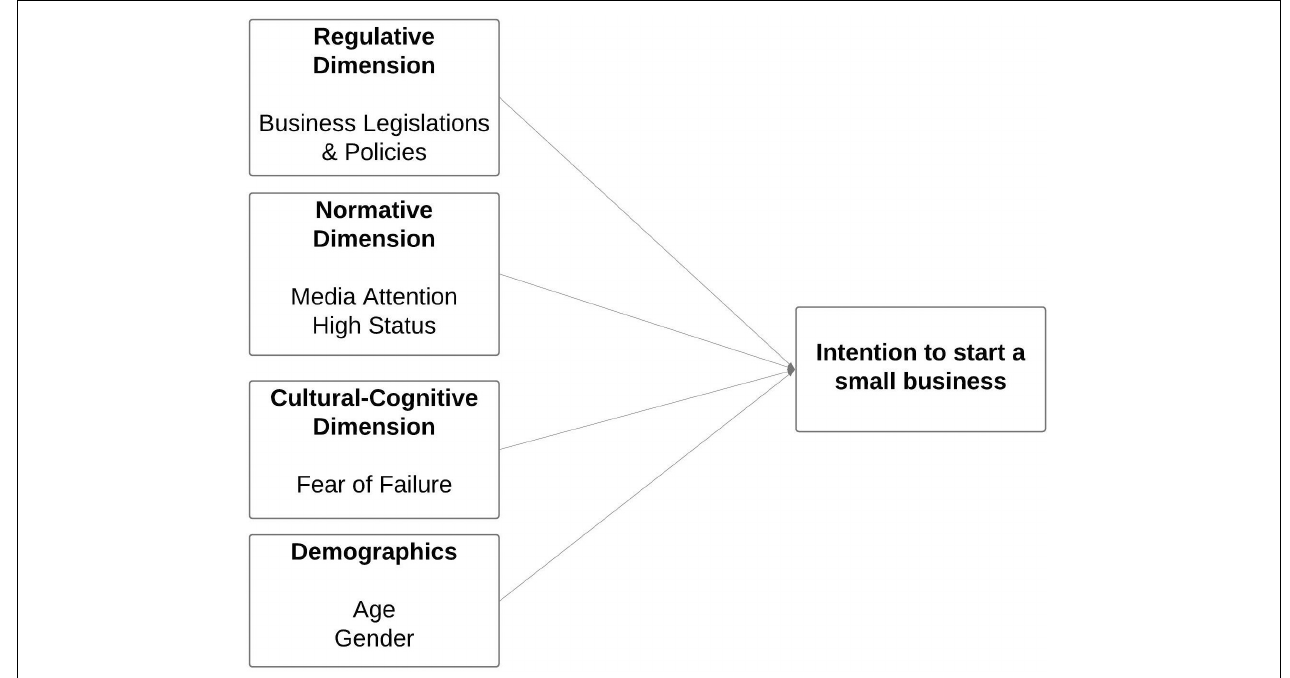
FIGURE 1 | Hypothesized Model. Source: Author’s